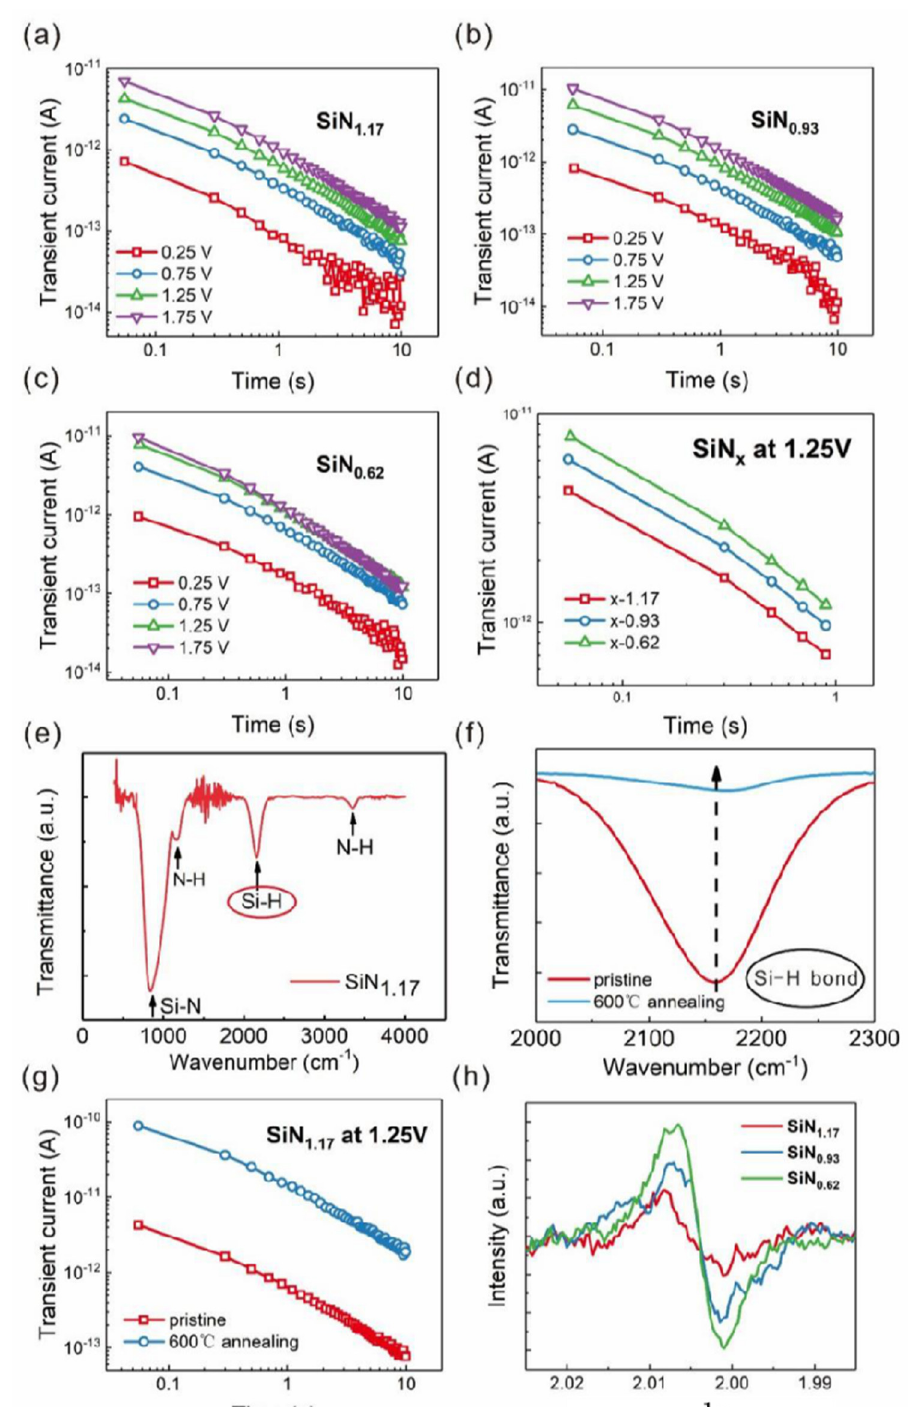
Figure 2. ( a–c ) Time-dependent transient current of the devices at the initial state with N/Si ratios of 1.17, 0.93, and 0.62. ( d ) Time-dependent transient current of the devices with N/Si ratios of 1.17, 0.93, and 0.62 at 1.25V. ( e ) The FTIR spectra of pristine a-SiN 1.17 :H films. ( f ) The evolution of Si–H absorption peak of a-SiN 1.17 :H in the magnified scale before and after 600 ℃ annealing. ( g ) Time-dependent transient current of a-SiN 1.17 :H before and after 600 ℃ annealing. ( h ) ESR spectra of the devices at the initial state with N/Si ratios of 1.17, 0.93, and 0.62. The DC sweep of the resistive switching process for an a-SiN 1.17 :H device by con- tinuously applying different reset voltages is shown in Figure 3a. The device